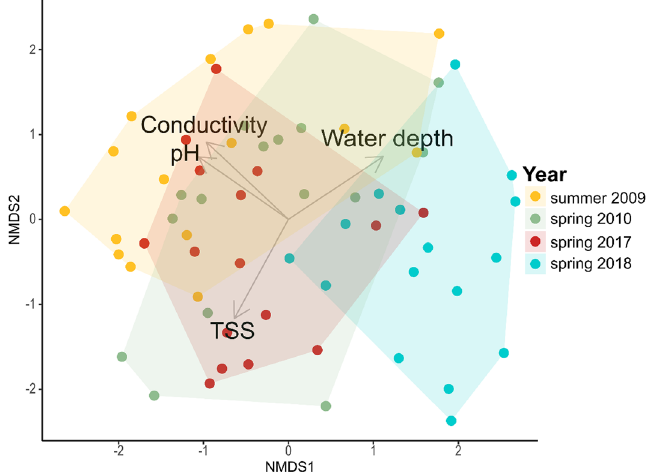
Figure 3. NMDS plot illustrating the separation of samples (each soda pan is represented by one filled circle per year) based on the local environmental variables in the Seewinkel regional data (2017: dry, 2018: wetter) and the earlier reference data (2009: summer, 2010: